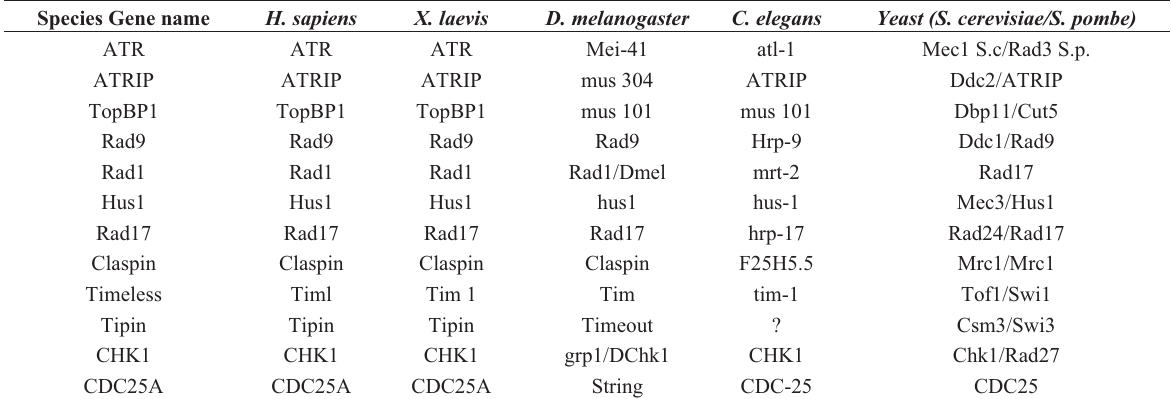
Table 1. List of proteins implicated in replication checkpoint activation from yeast to human. Question marks indicate possible homologous genes or those not yet identified